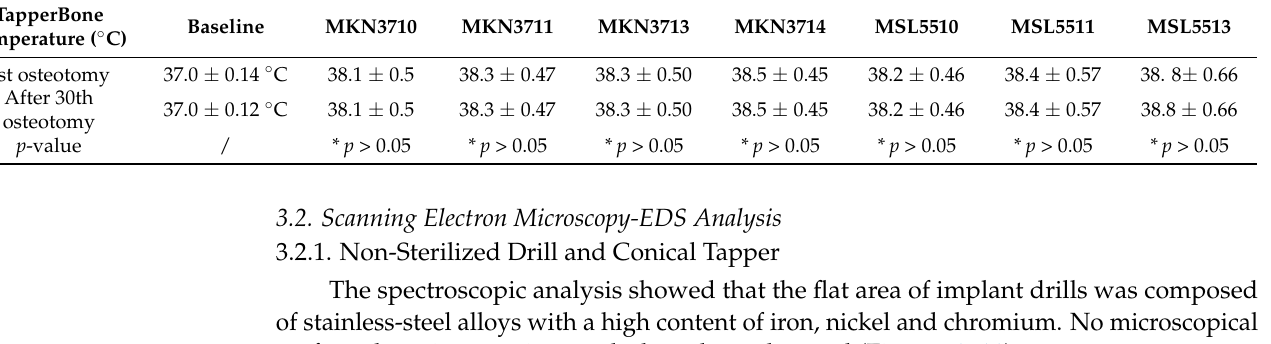
Figure 9. Details of the SEM analysis of the drills used in the present experiment (Mag. 2.16 Kx).